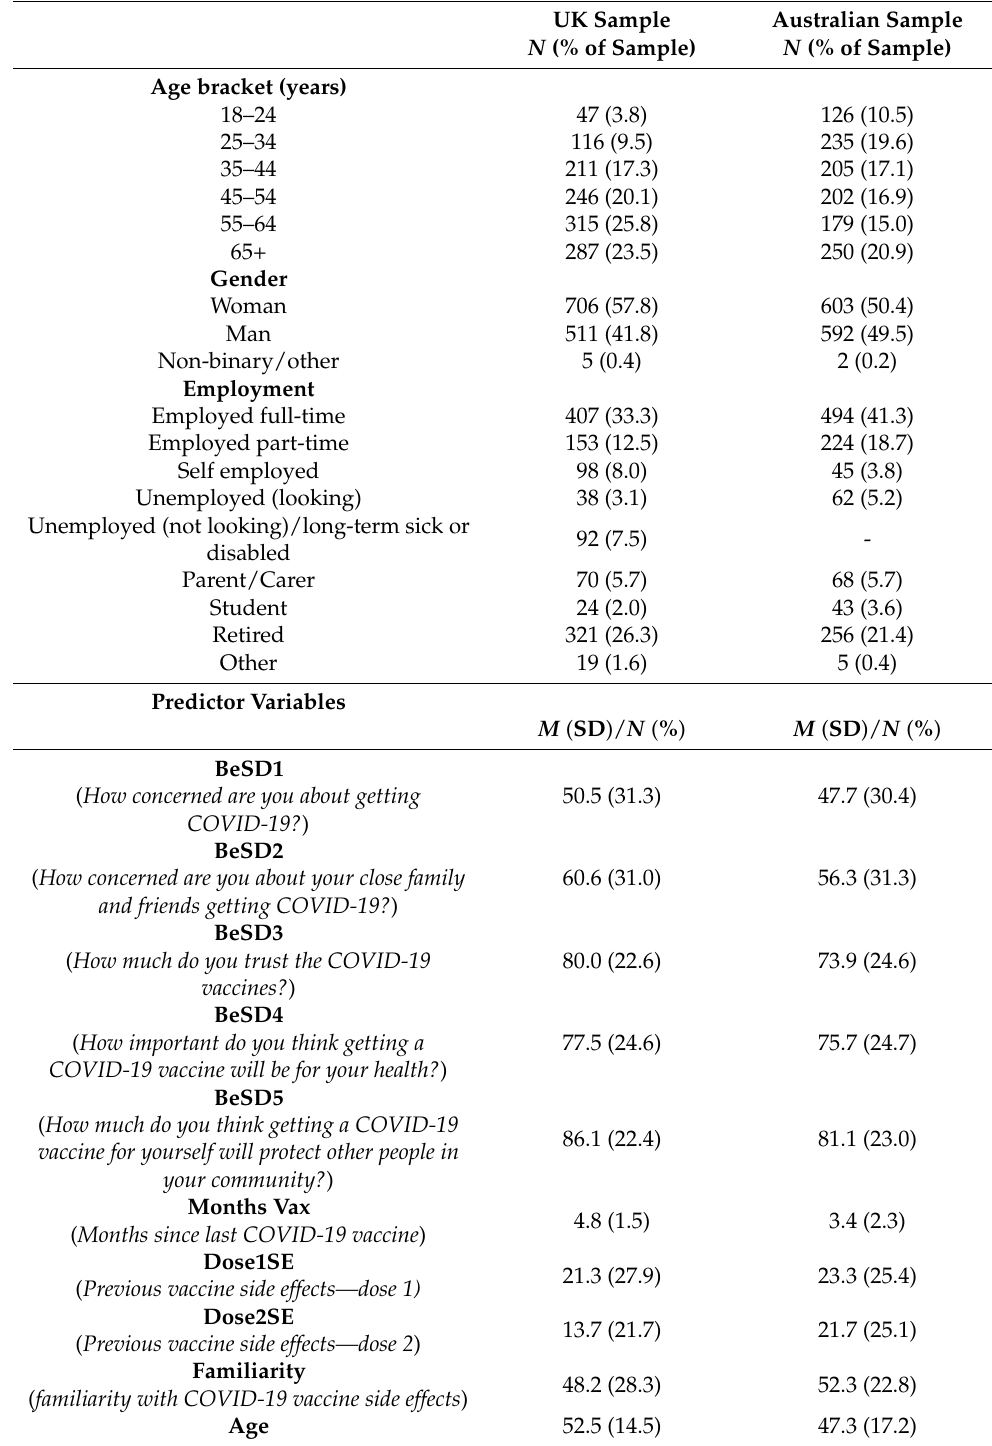
Table 1. Basic demographic information regarding the characteristics of the sample (additional information can be found in the following sources [18,19]) and descriptive statistics regarding the predictors in the UK and Australian models. These are presented as means ( M ) and standard deviations ( SD ), or frequency counts ( N ) and percentages ( % ), dependent on the type of measure (i.e., scale vs.